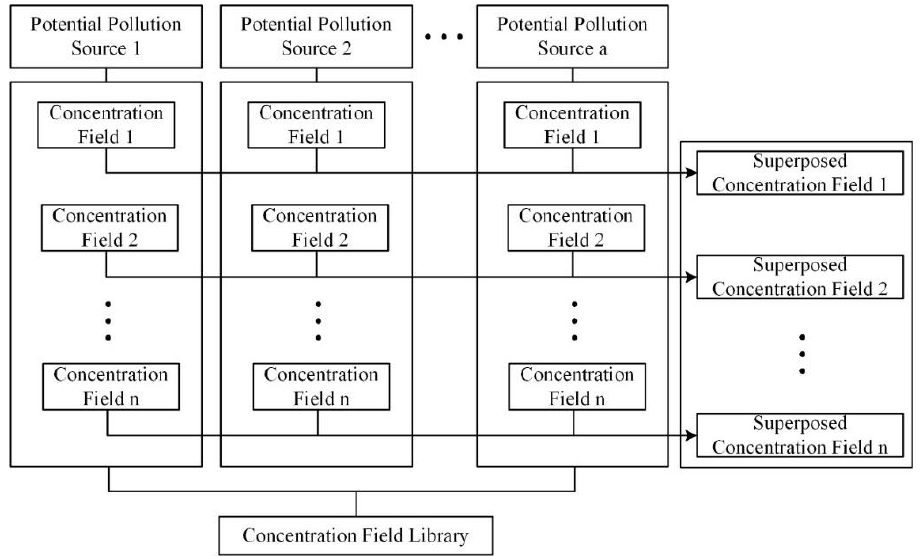
Figure 2. The construction diagram of the concentration field library. Given the weight and mass-loading rate of potential pollution sources (( w j , m j ), j = 1, …, a), the concentration field corresponding to each hydraulic conductivity realization is generated utilizing the following procedures (Figure 3). First, according to the weight value of each pollution source,